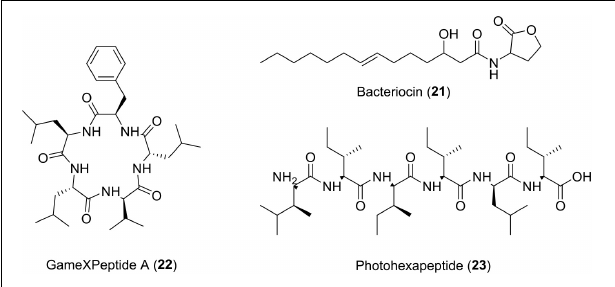
FIGURE 8 | Chemical structure of other compounds (21–23)